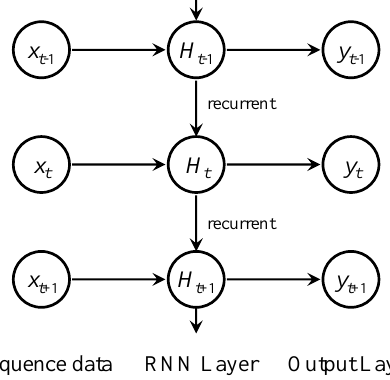
Figure 2. Basic structure of a recurrent neural network (RNN). Chain-like characteristics of RNNs show the advantages of analyzing sequence data.